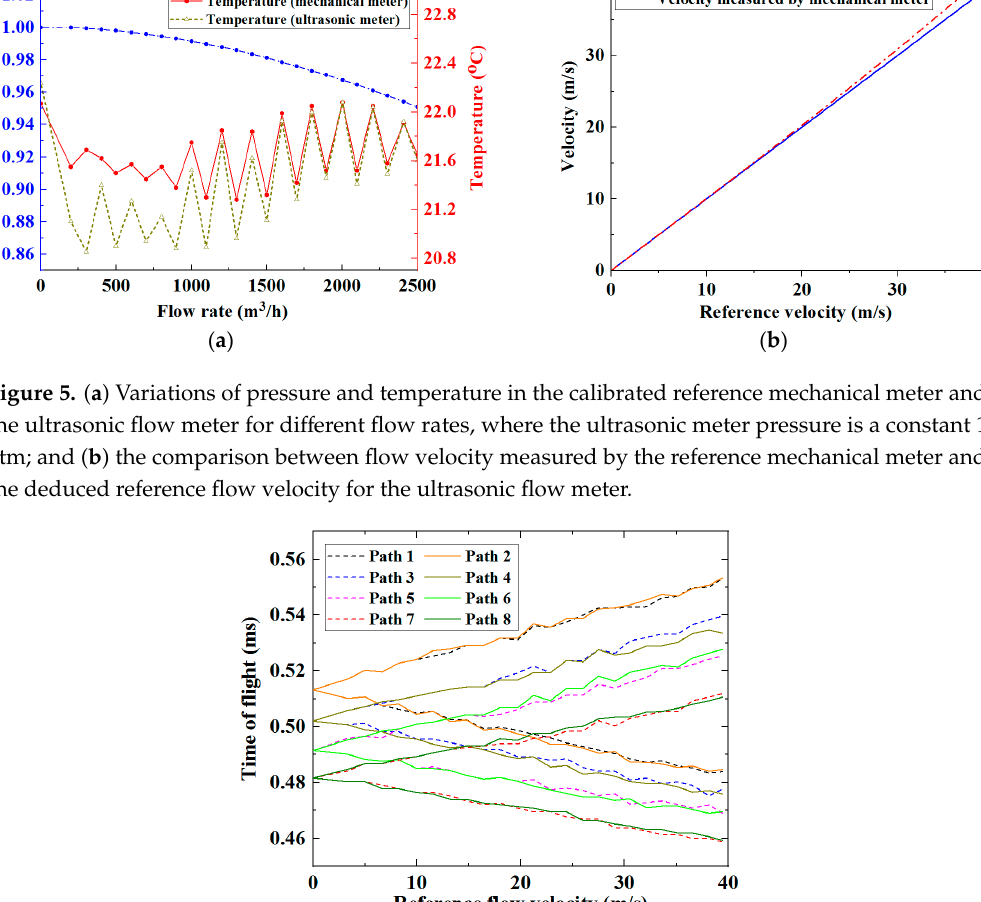
Figure 6. ToFs for ultrasonic waves travelling through the eight paths upstream and downstream at different flow velocities.